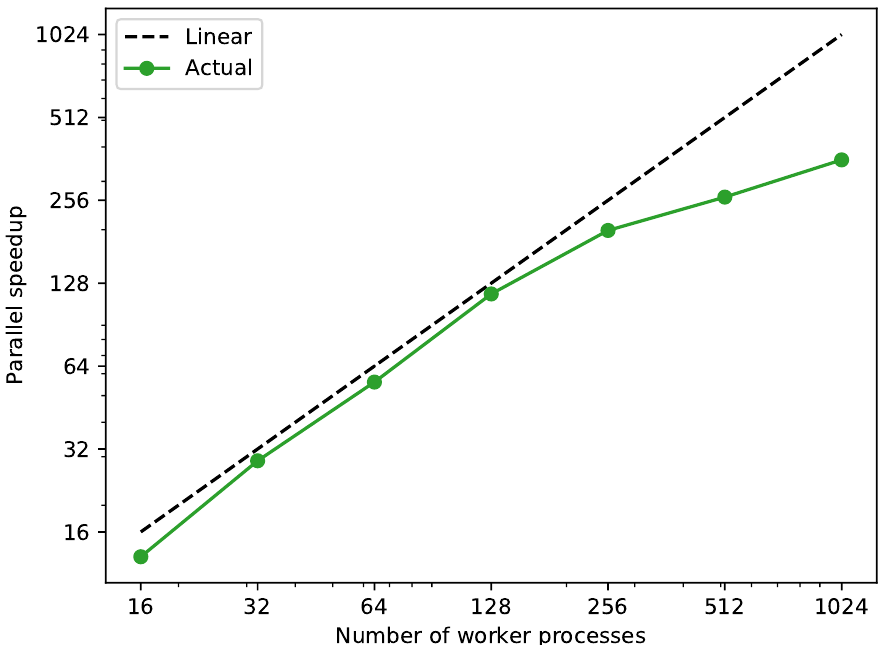
Figure 7. Parallel speedup against sequential simulation of the 2400 scenarios generated in test case 2 with a different number of worker